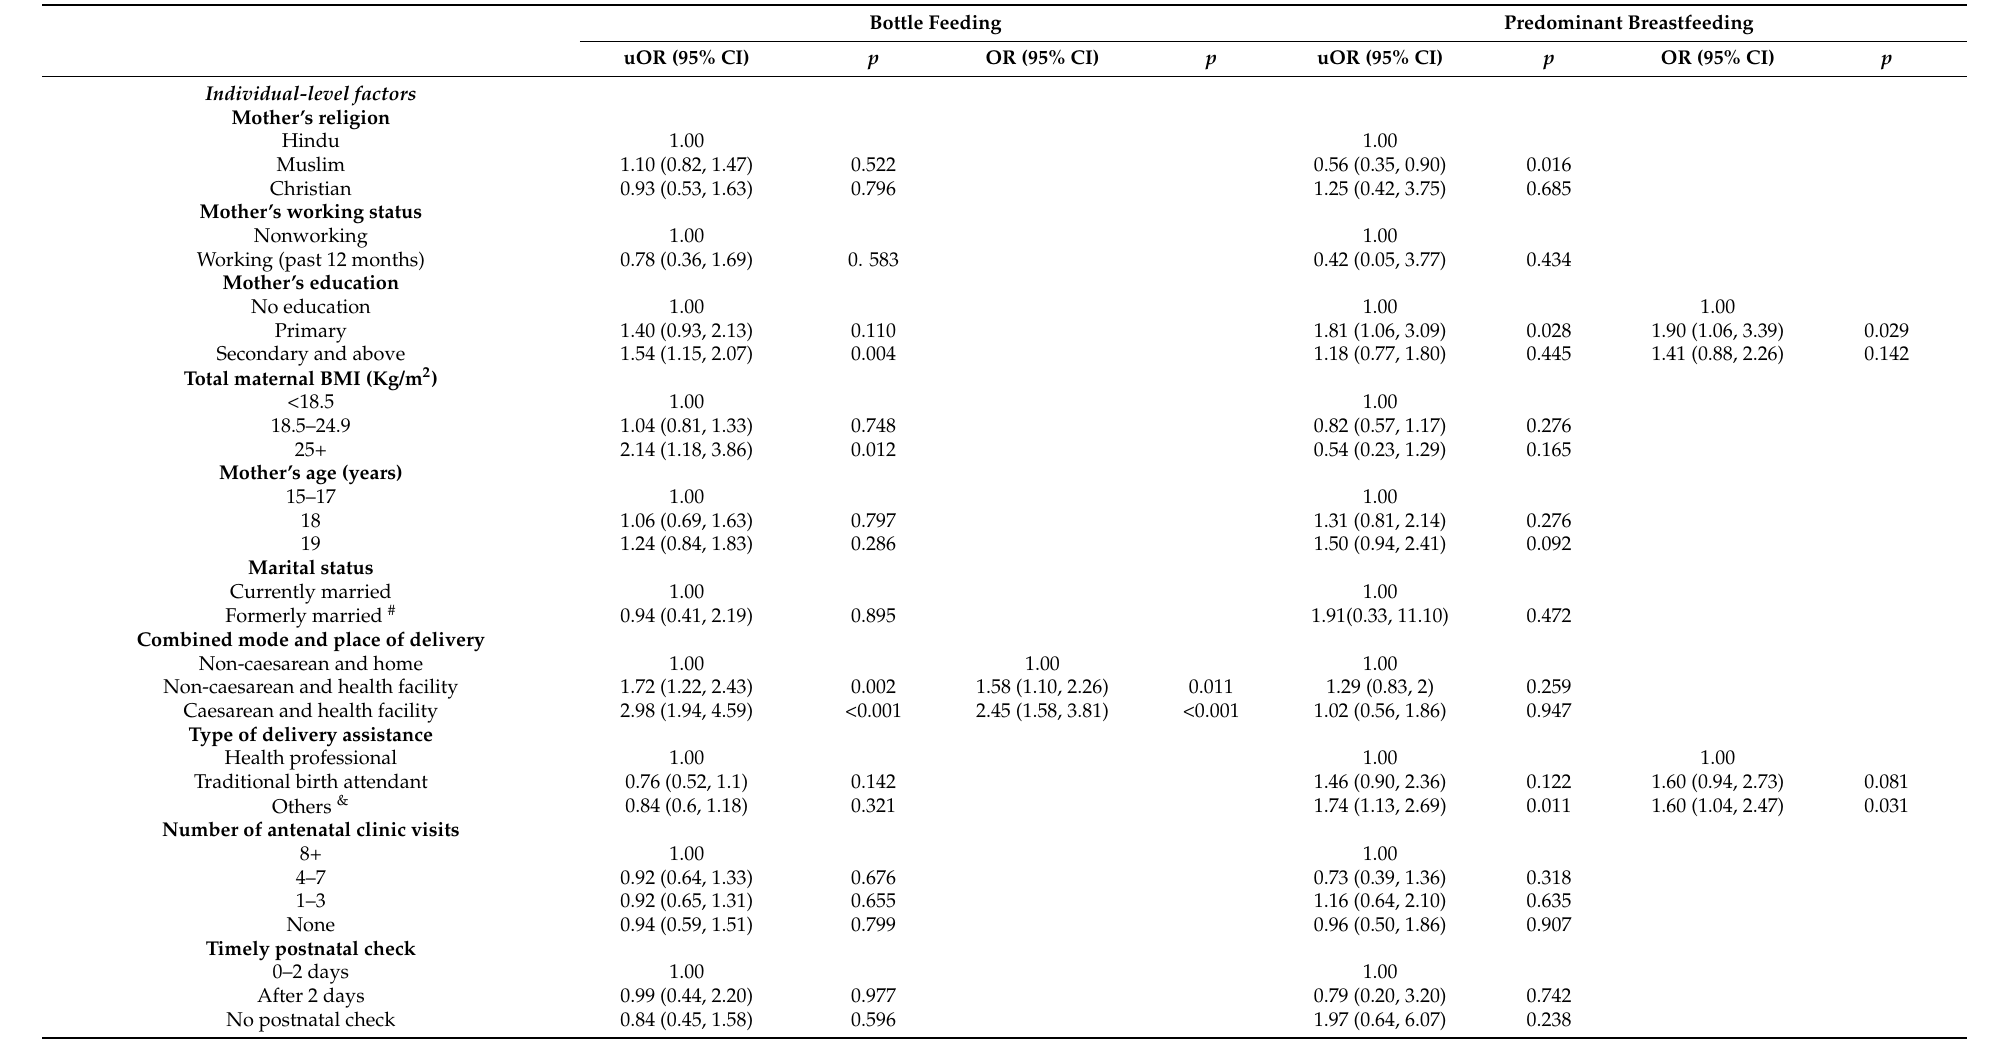
Table 4. Factors associated with bottle feeding and predominant breastfeeding in adolescent Indian mothers, 2015–2016 NFHS. Bottle Feeding Predominant